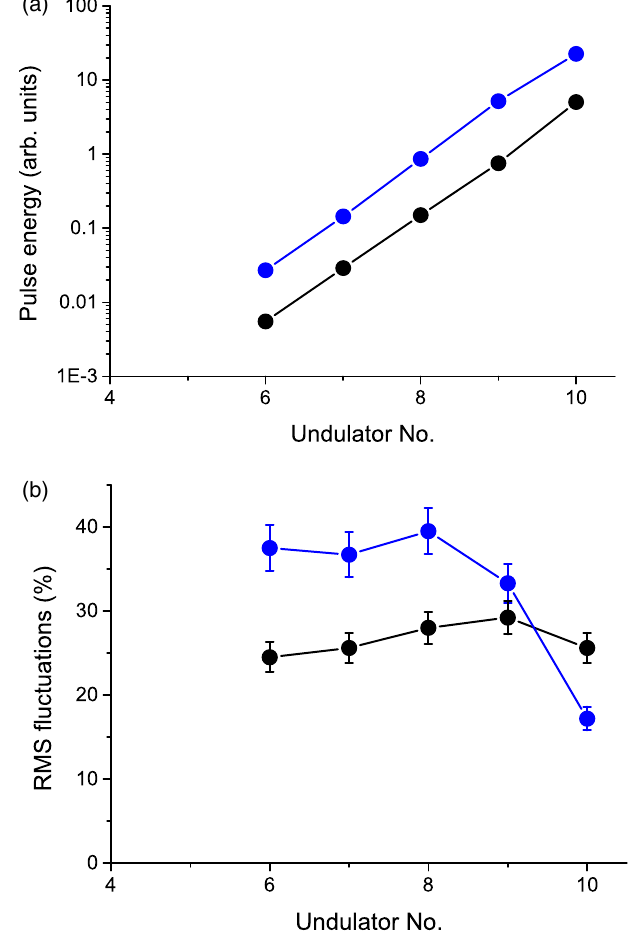
FIG. 6. Radiation pulse energy (left plot) and pulse energy fluctuations (right plot) in the second part of the undulator for HLSS (blue) and for SASE (black). Small aperture in front of the MCP detector is used in this